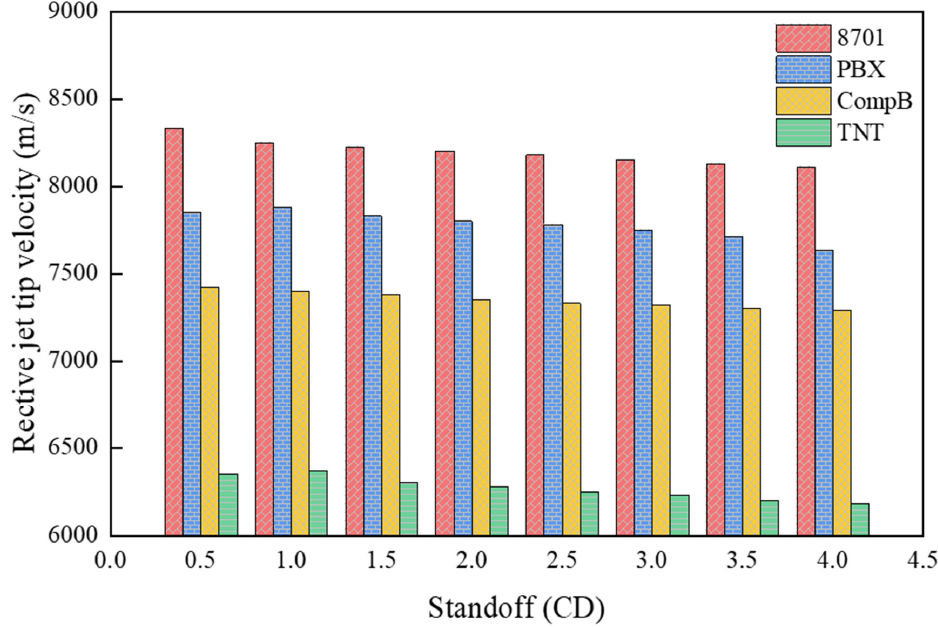
Figure 10. The tip velocity of the reactive composite jet influenced by